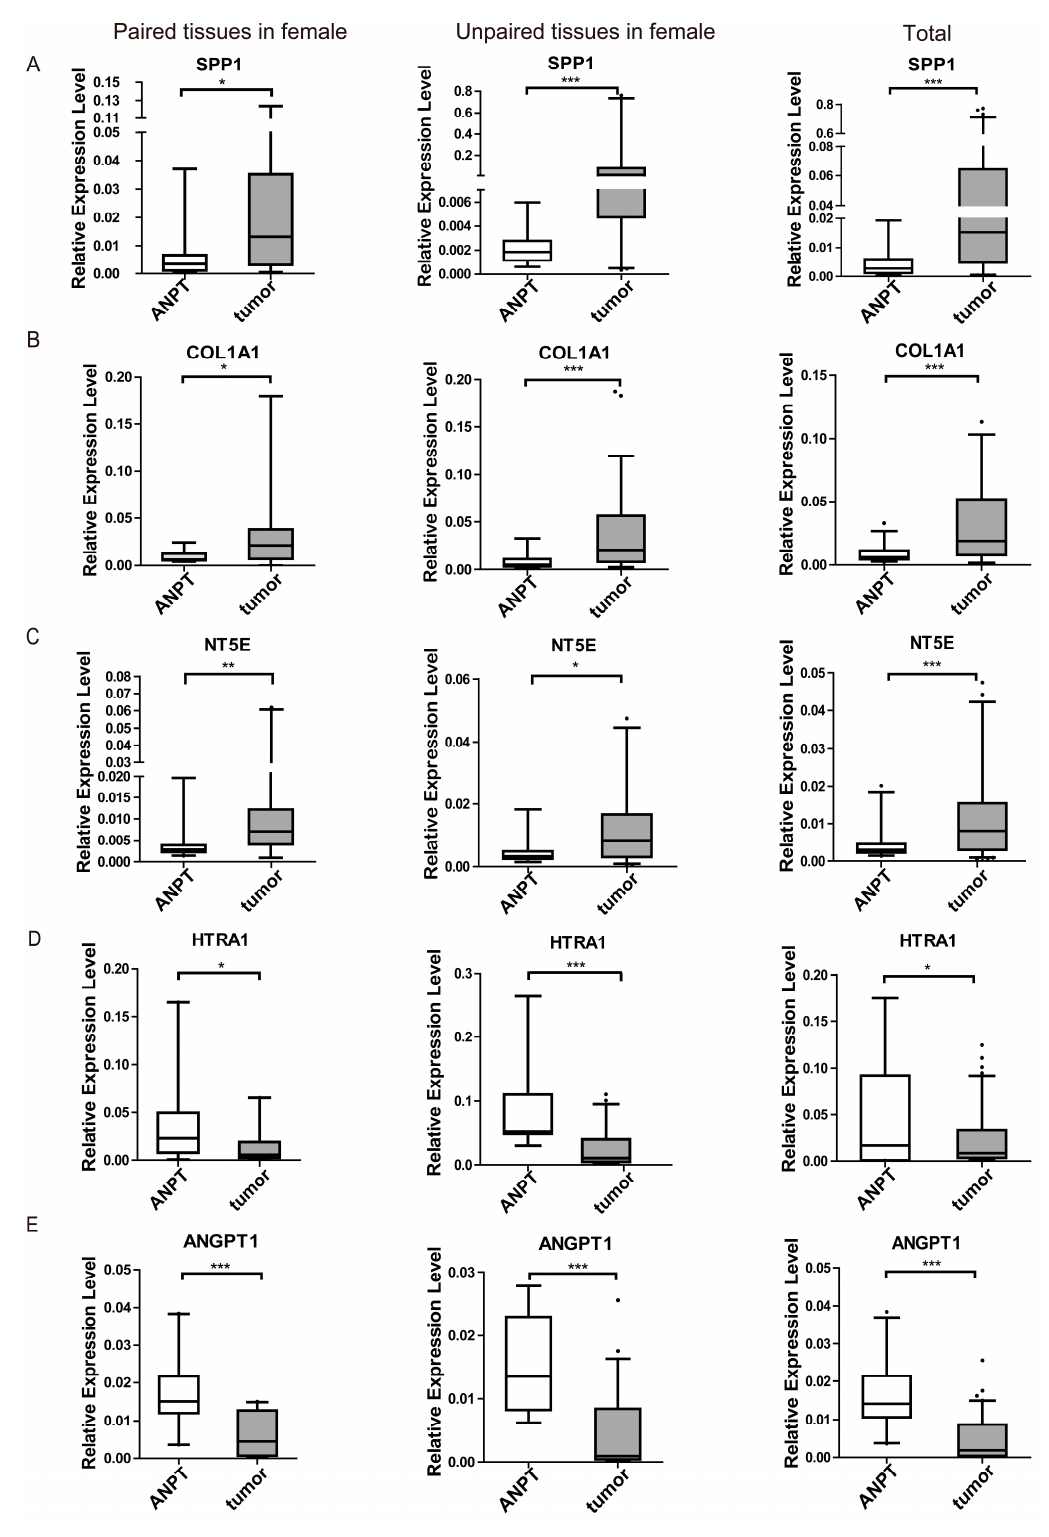
Figure 3. Gene expression profile of ACTH-secreting pituitary adenomas using qRT-PCR. A comparison of expression levels of SPP1 ( A ), COL1A1 ( B ), NT5E ( C ), HTRA1 ( D ) and ANGPT1 ( E ) between ANPT and ACTH-secreting pituitary adenomas using qRT-PCR including 29 female paired pituitary tissues, 63 female unpaired tissues (ANPT, n = 13; tumor, n = 50) and 109 total tissues (female, n = 92; male, n = 17). The data are representative of three technical repeats in the median (quartiles) (Mann-Whitney test, * p < 0.05, ** p < 0.01, *** p < 0.001. ANPT versus tumors).